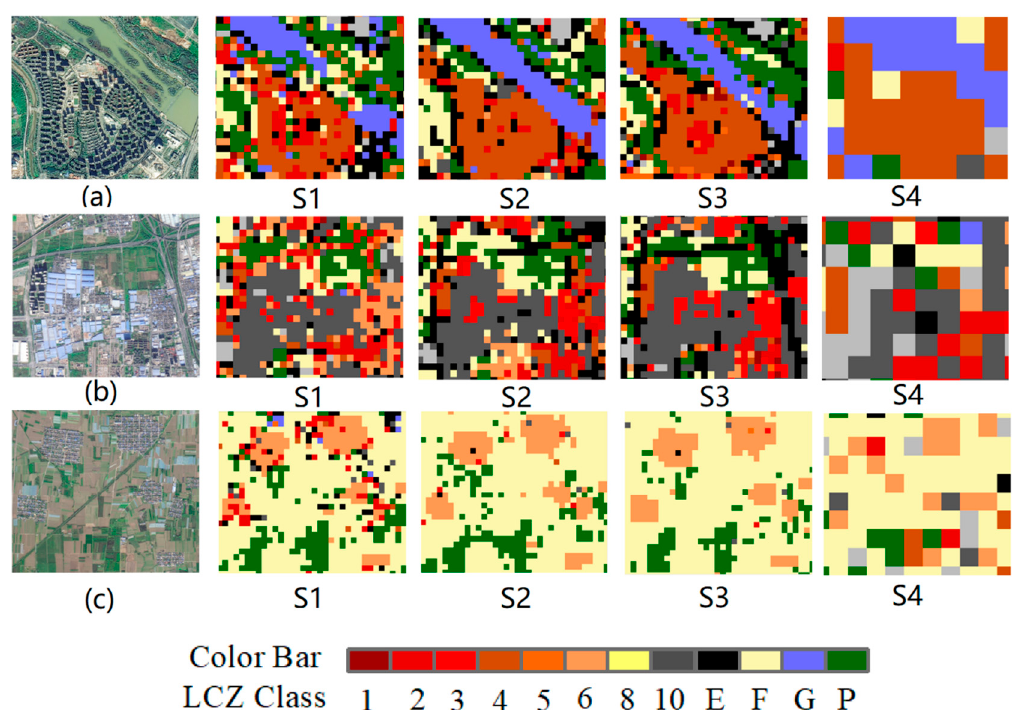
Figure 7. LCZ classification results for three localized regions of ( a – c ). The GF-6 image is shown on the left, and the LCZ results of the four schemes are shown on the right.